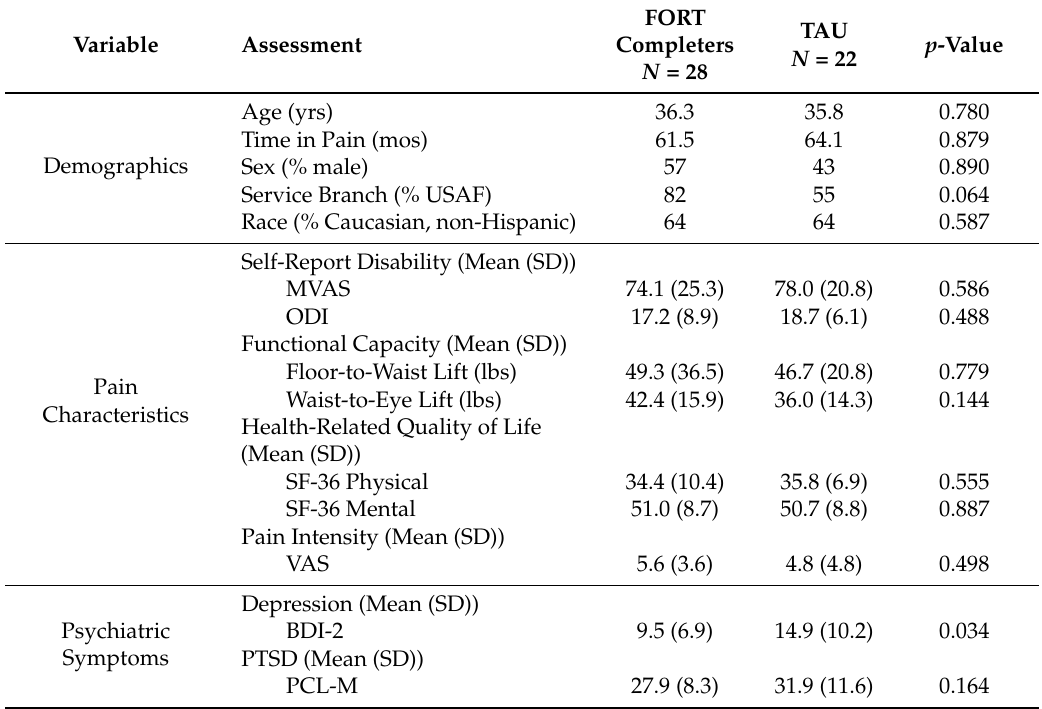
Table 1. Comparison of pre-treatment demographic, pain and psychiatric variables between Functional and Orthopedic Rehabilitation Treatment (FORT) completers and non-completers (who were given treatment as